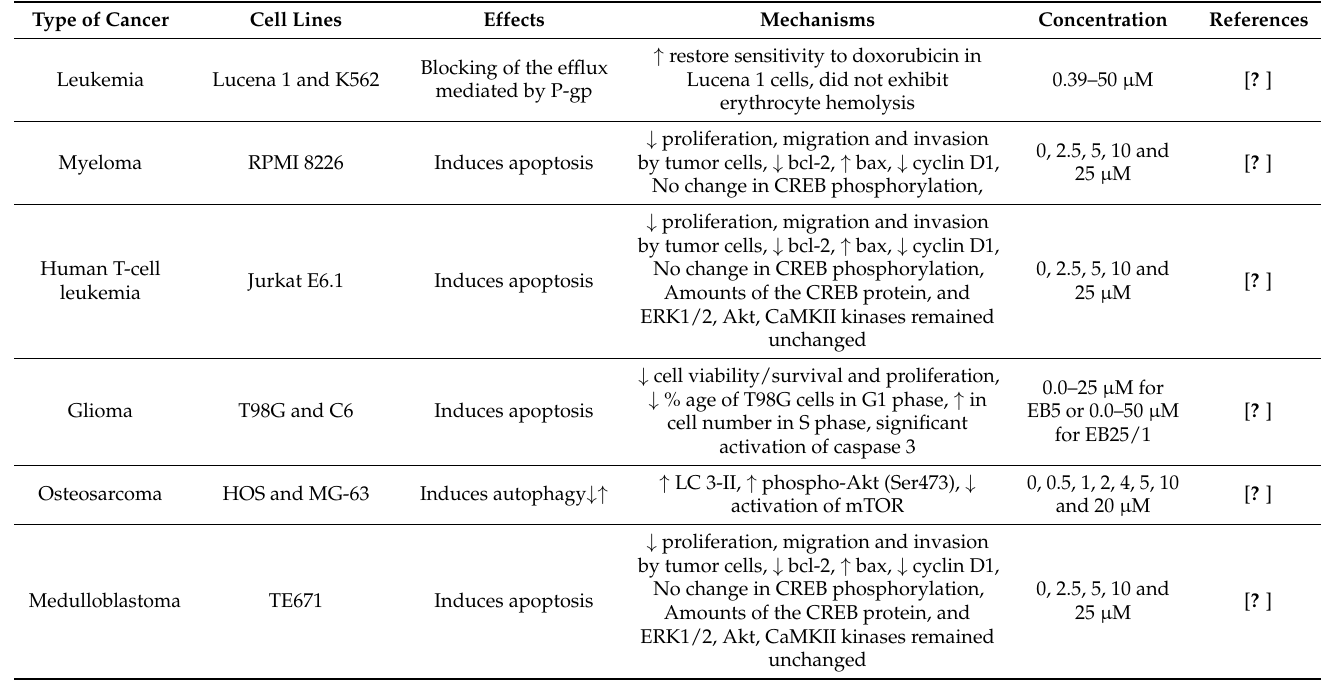
Table 1. Anticancer effects of betulin and betulinic acid based on in vitro studies. Type of